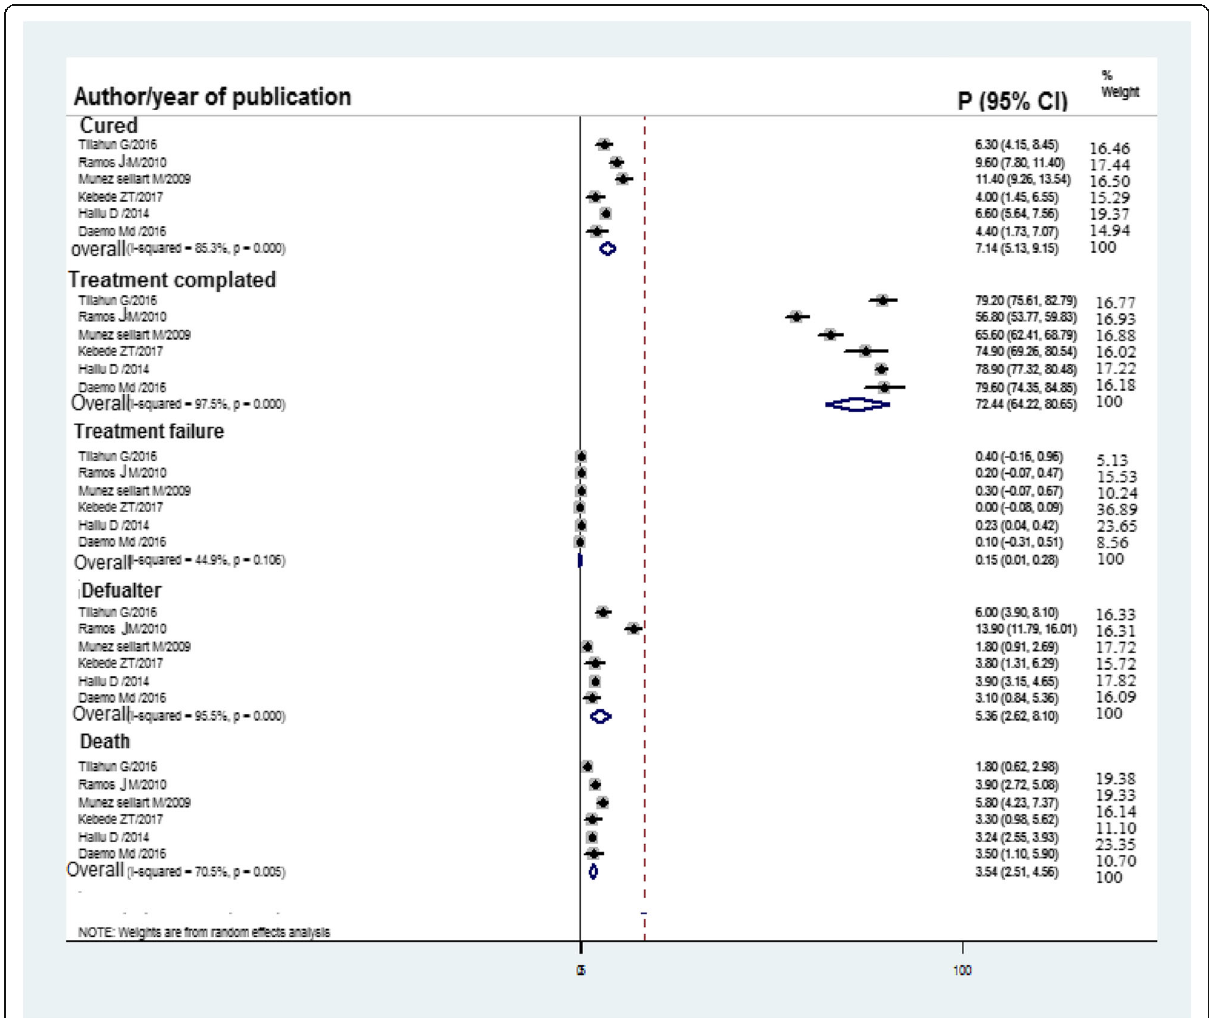
Fig. 4 Forest plot of TB treatment